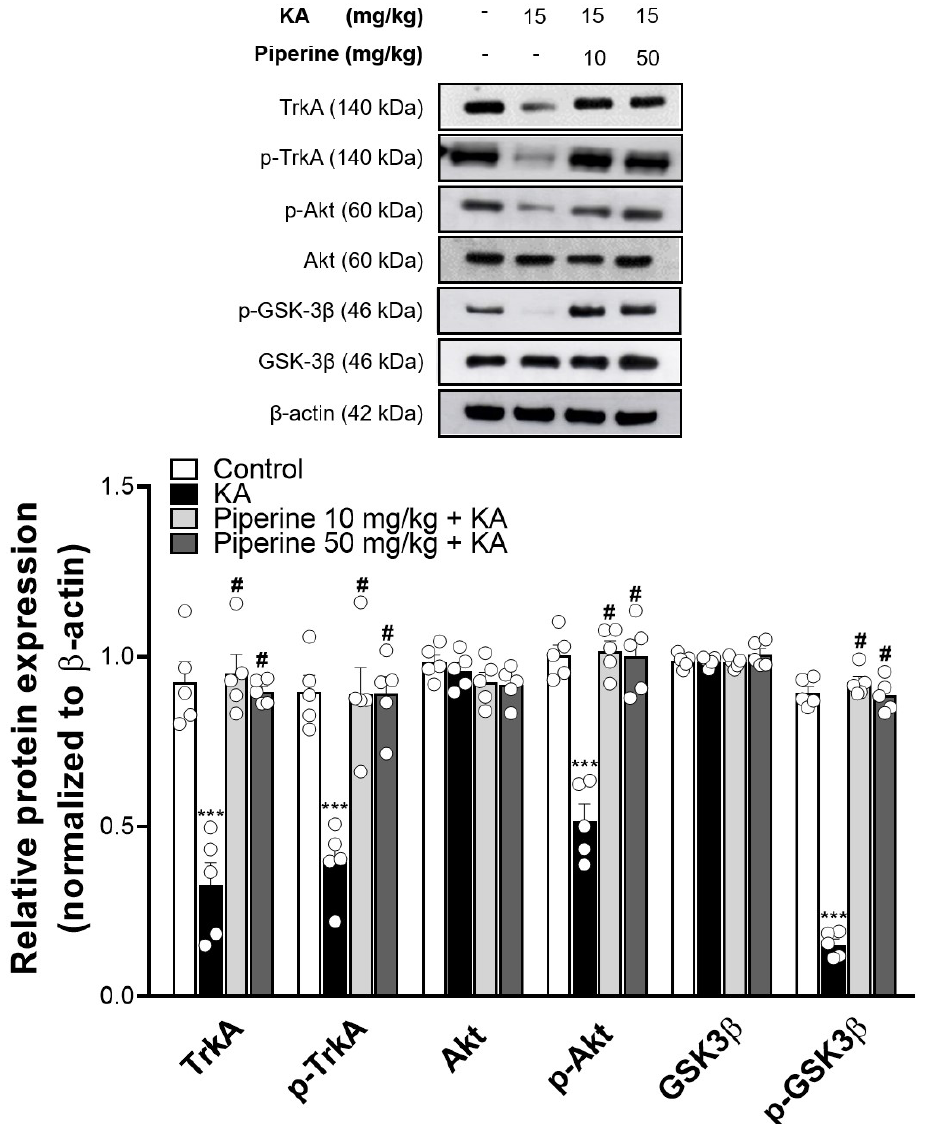
Figure 6. Effect of piperine pretreatment on TrkA, p-TrkA, Akt, p-Akt, GSK3 β , and p-GSK3 β protein levels in the hippocampus of KA-treated rats. The upper panel shows a representative Western blot. The lower panel is the relative density bar graph. Quantification of each protein was normalized to β -actin. Data are presented as the means ± S.E.M. (n = 5). # p < 0.001 versus the KA group; *** p < 0.001 versus the control group (ANOVA/Scheffé).